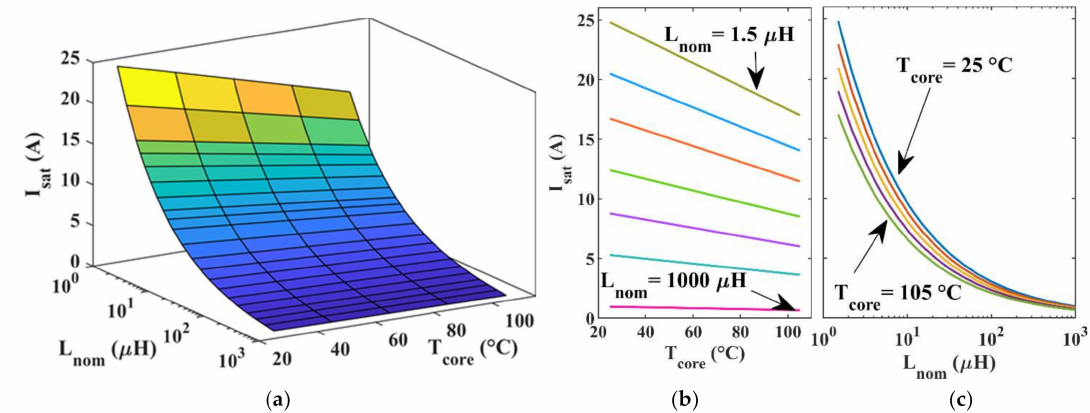
Figure 7. Saturation current behavior for the inductor family simulated from (13) and (15): ( a ) saturation current ( I sat ) vs. nominal inductance ( L nom ) vs. core temperature ( T core ); ( b ) I sat vs. T core for a given L nom ; ( c ) I sat vs. L nom at constant T core . The inductance axis is on a logarithmic scale for better